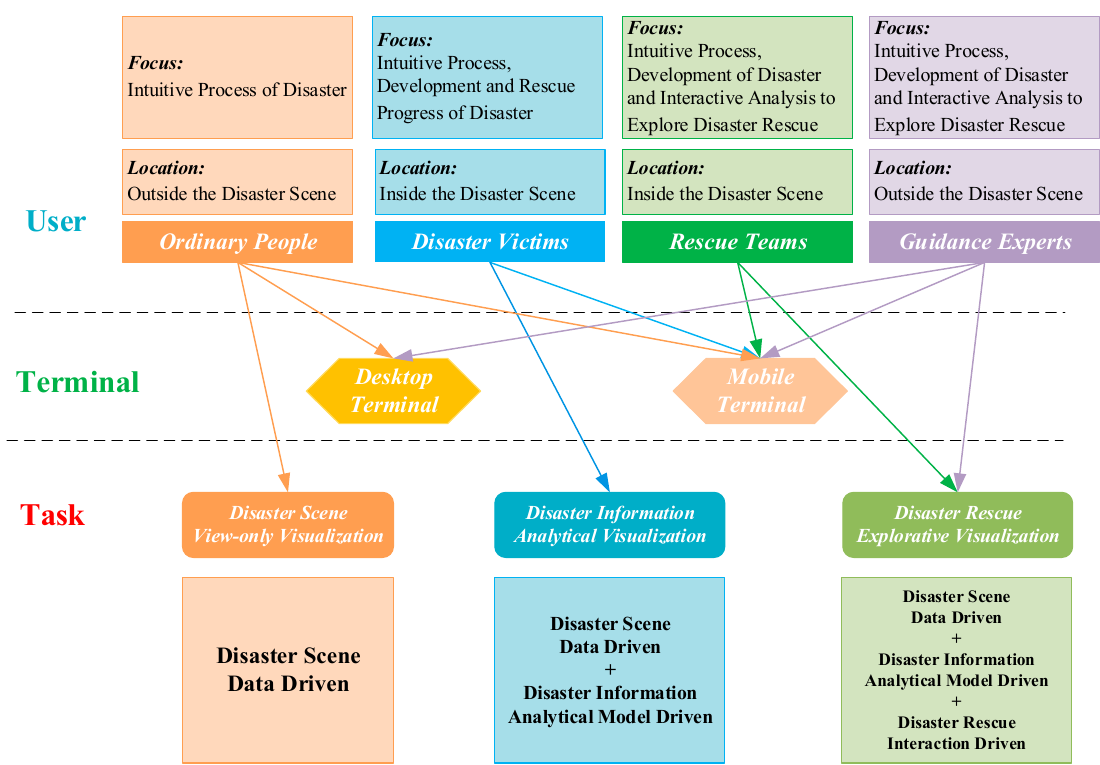
Figure 2. Multilevel visualization task model for disaster emergency response.